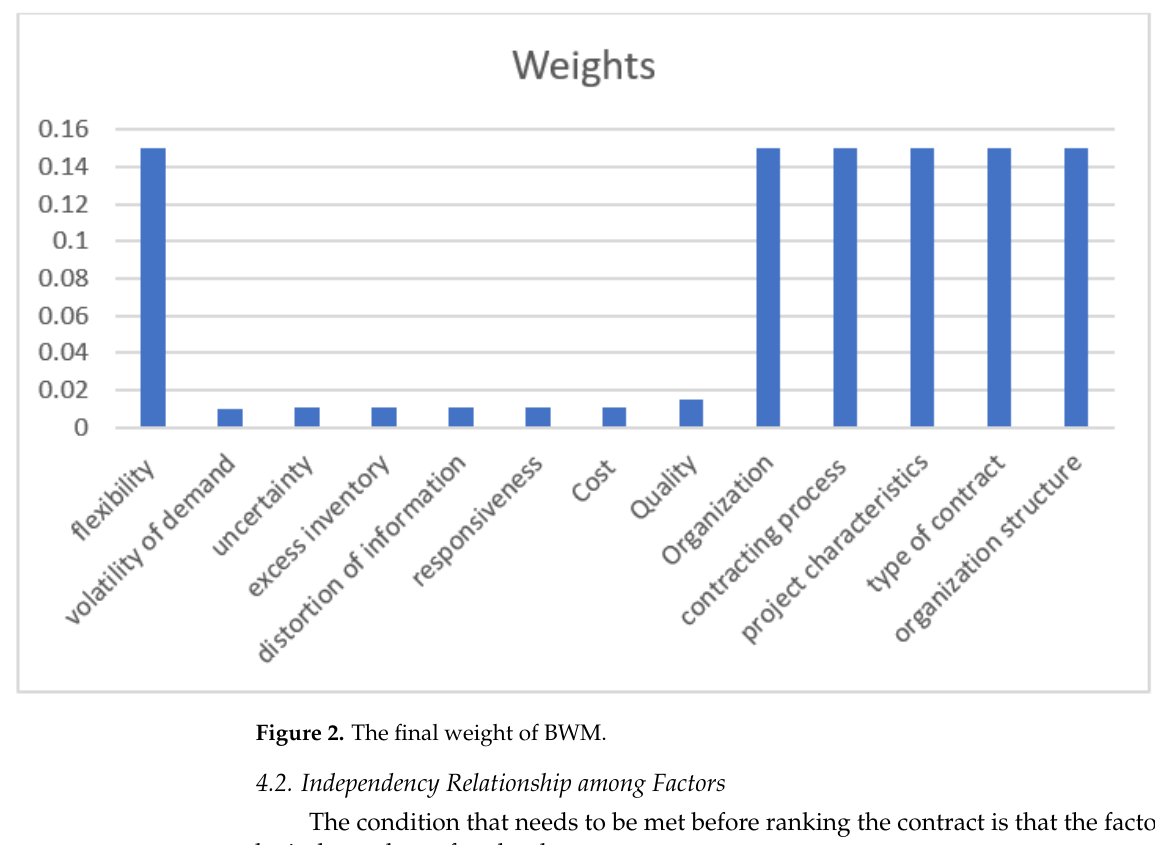
Table 8. Decision matrix of the gray relational analysis